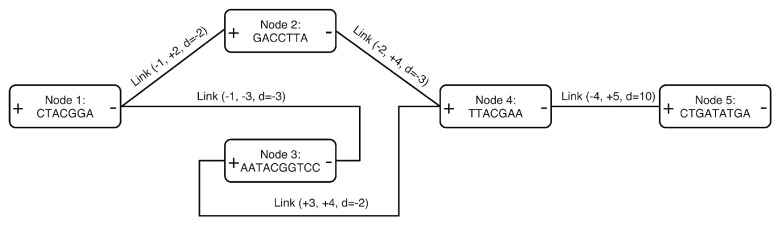
A simple Sequence Distance Graph with 5 nodes, including links with d<0, representing overlaps, and a link representing a gap of 10bp.Sequences appear in only one direction and their reverse complement can be obtained by traversing the node in opposite direction, from - to +. The two largest possible paths are [1, 2, 4, 5] and [1, -3, 4, 5], and their reverse complements [-5, -4, -2, -1] and [-5, -4, 3, -1] respectively.